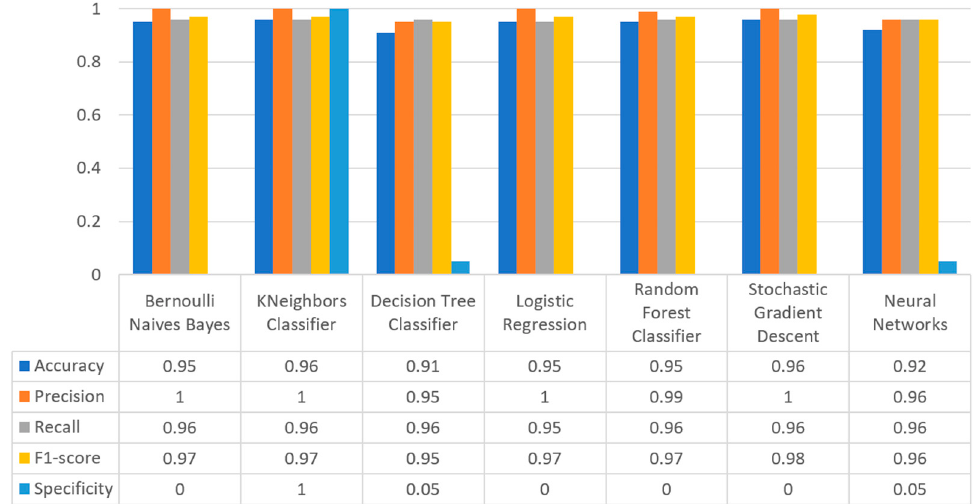
Figure 26. Performance comparison in the COVID-19 use case.